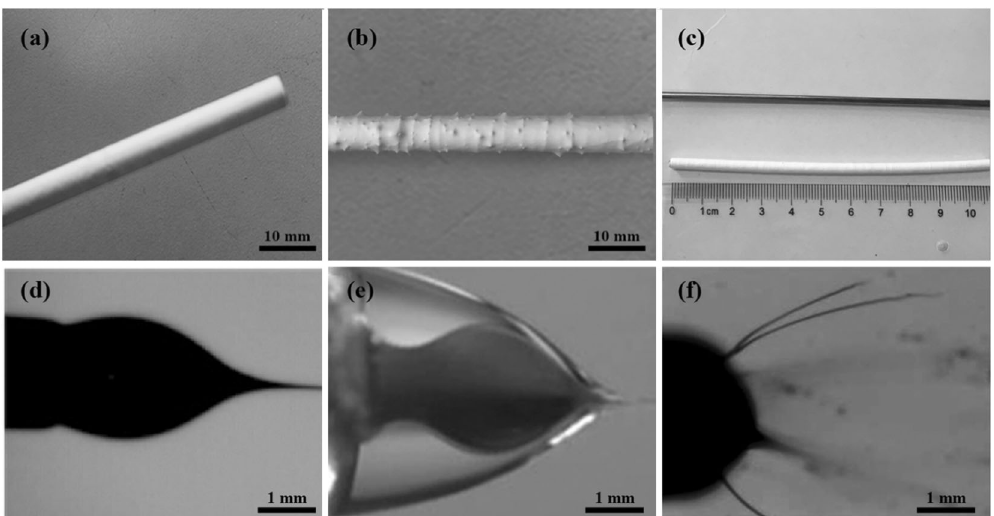
Fig. 3 Macroscopic morphology of bioarti fi cial blood vessels: a Without thorn-like protrusions. b With thorn-like protrusions. c Receiving shaft and bioarti fi cial blood vessel. d Stable uniaxial Taylor cone structure. e Stable coaxial Taylor cone structure. f Unstable Taylor cone